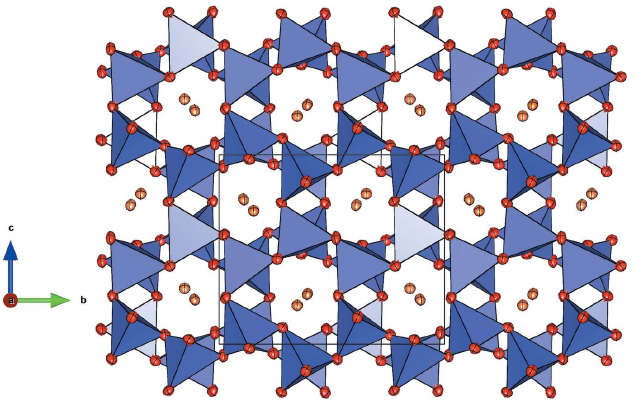
Figure 1 Projection of the framework structure along [100]. [ T O 4 ] tetrahedra are shown in blue. Oxygen and strontium atoms are given in red and orange, respectively. Displacement ellipsoids are drawn at the 70% probability level.